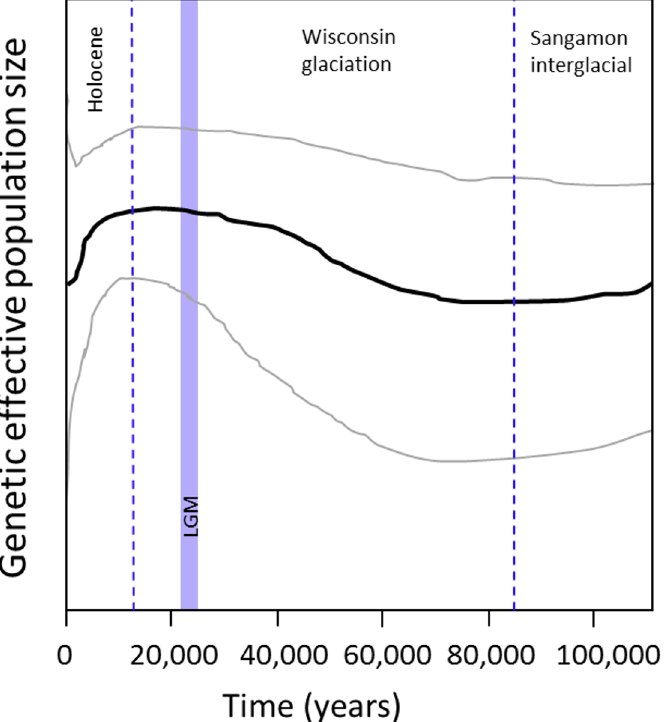
Fig 5. Bayesian skyline plot illustrating Pleistocene increase and Holocene decline in population size of western Urocyon based on 785 bp of concatenated cytochrome b and D loop sequence data. The black line represents the median population size, while the lines above and below represent the 95% highest posterior density (HPD). Dashed lines indicate glacial-interglacial boundaries and the blue shaded rectangle indicates the last glacial maximum (LGM) for reference to the population sizes. The estimated root height (coalescence time) was 96,860 years (95% HPD: 55,318 – 144,274 years) or 48,380 generations (assuming a 2-year generation